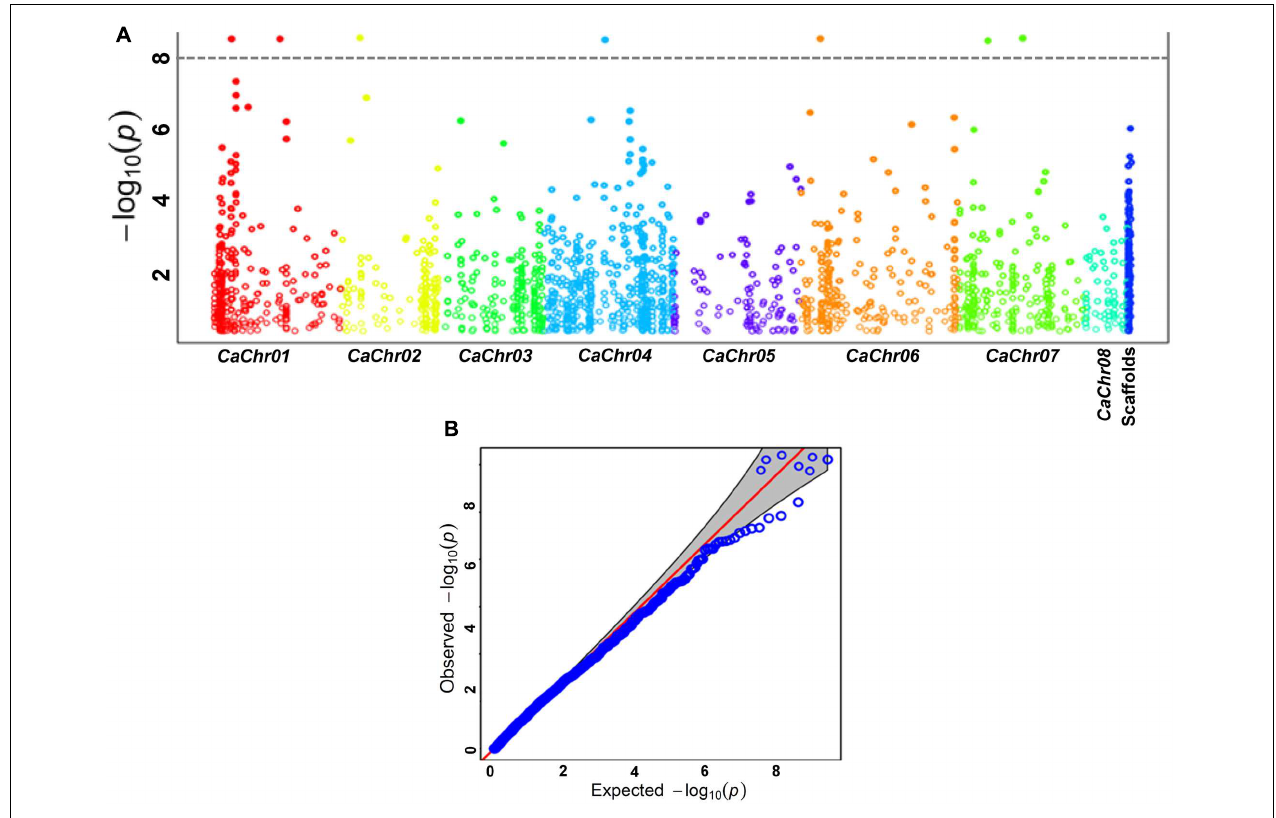
FIGURE 3 | (A) GWAS-based Manhattan plot illustrating significant P -values (measured by CMLM model) associated with seed-protein content (SPC %) using 16376 genome-wide GBS-SNPs in chickpea. The x-axis represents the relative density of SNPs physically mapped on eight chromosomes and scaffolds of kabuli genome. The y -axis denotes the –log 10 ( P )-value for significant association of seven SNPs with SPC trait. The SNPs revealing significant association with SPC trait at cut-off P -value ≤ 1 × 10 − 8 are demarcated with dotted lines. (B) Quantile-quantile plot depicting the comparison between expected and observed –log 10 ( P )-values at a FDR cut-off < 0.05 to scan the significant genomic SNP loci associated with SPC trait in chickpea.